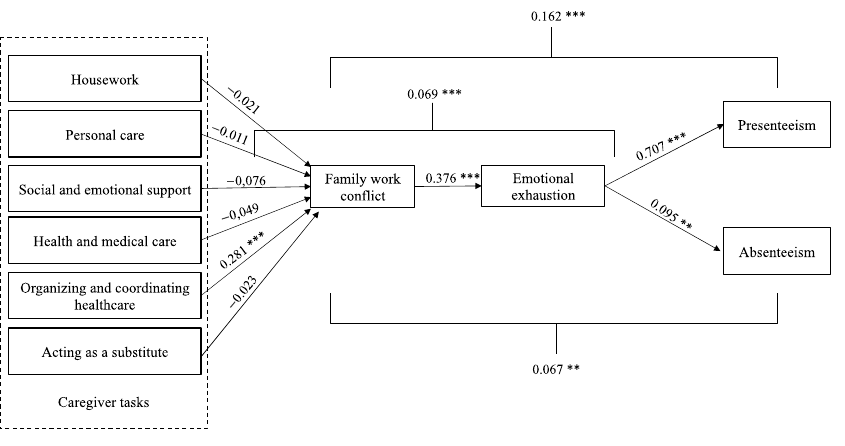
Figure 2. The final structural model with standardized path coefficients ** p < 0.01, *** p < 0.001 .